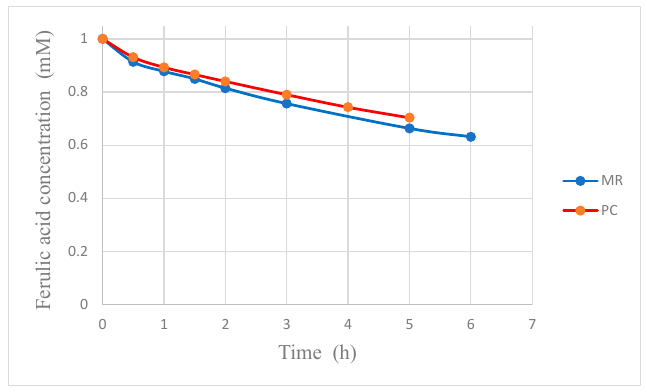
Figure 9. Ferulic acid (FA) concentration in the reactor vs. time. The operating conditions are the same as those in Figure 8.